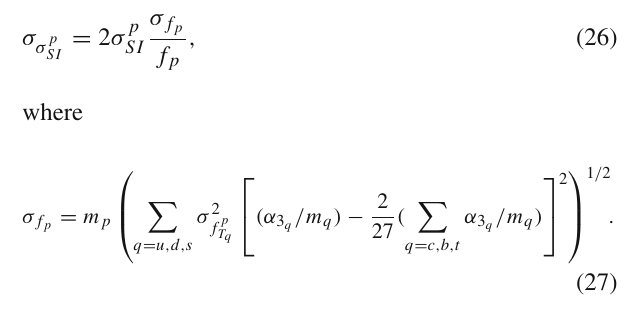
Fig. 6 Left: σ p vs (cid:7) π N for σ s = 30 , 50 , 100 MeV. Right: σ p SI uncertainty in the elastic cross